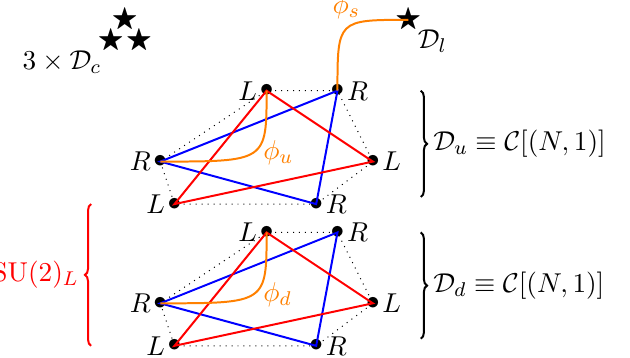
Figure 23. Brane con(cid:12)guration towards the Standard Model. Both D u and D d can be realized e.g. by rigged ( N; 1) brane solutions, which decompose into L and R sheets with 3